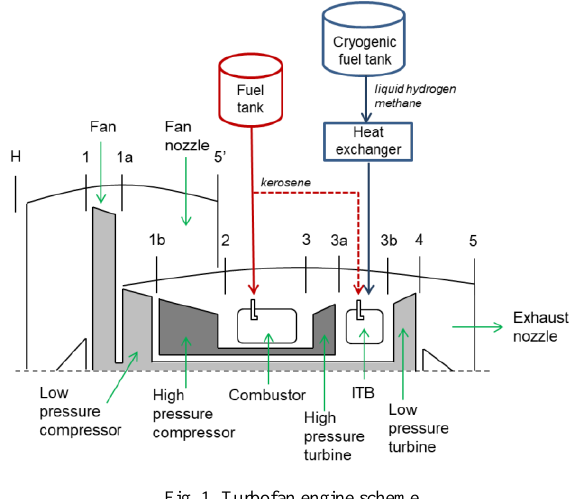
Fig. 1. Turbofan engine scheme